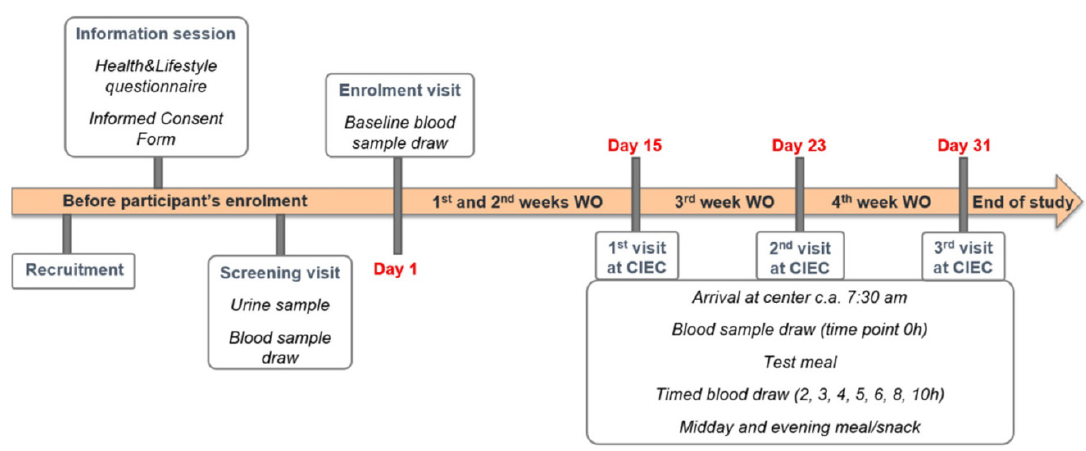
Figure 2. Representative scheme of the participants’ schedule during the trial phase. WO: Washout.